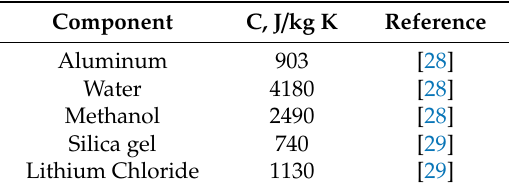
Table 4. Specific heat capacity C of inert components of the "adsorbent – heat exchanger" (AdHEx) tested in